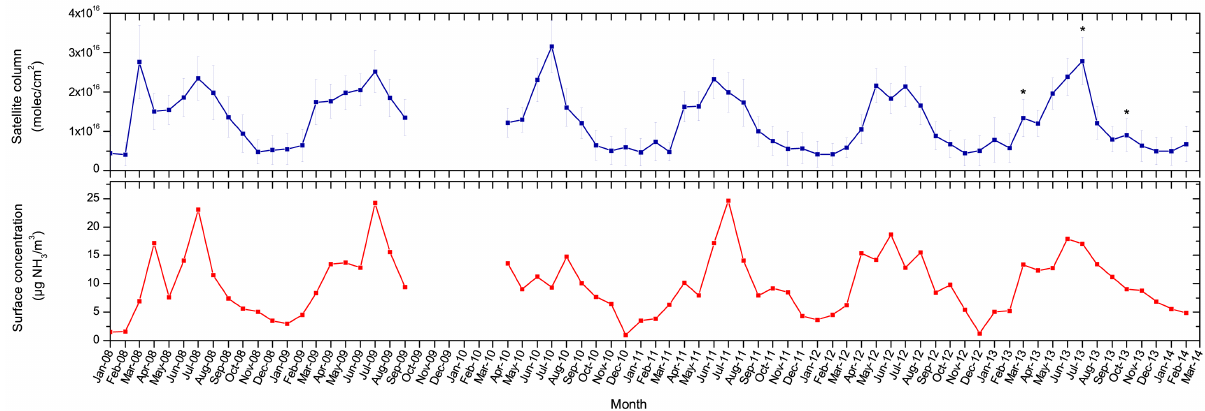
Figure 4. Time series of monthly averaged NH 3 satellite columns (top, blue, moleccm − 2 ) and ground-based concentrations (bottom, red, µgm − 3 ) at Shangzhuang site (40.14 ◦ N, 116.18 ◦ E) in the North China Plain (NCP) from January 2008 to February 2014. The associated weighted mean error for each month is calculated following equations described in Van Damme et al. (2014a) and presented here as error bars. Asterisks highlight the fertilization peaks of March, July and October 2013 (Shen et al.,